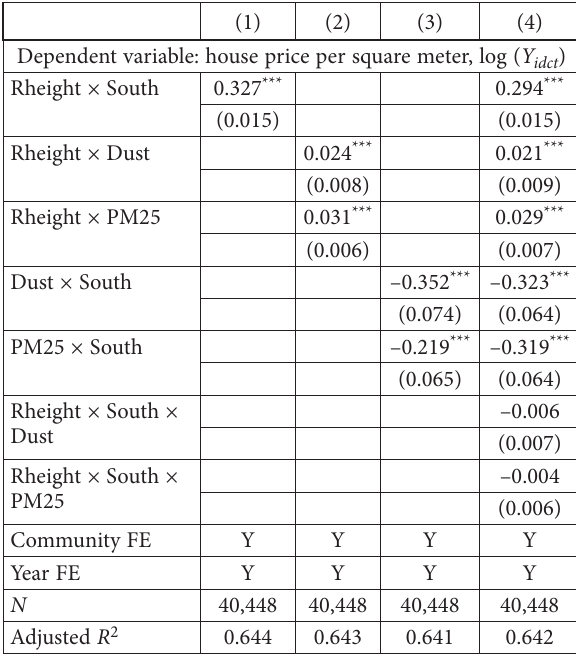
Table 3. The regression results of the extended model (2)